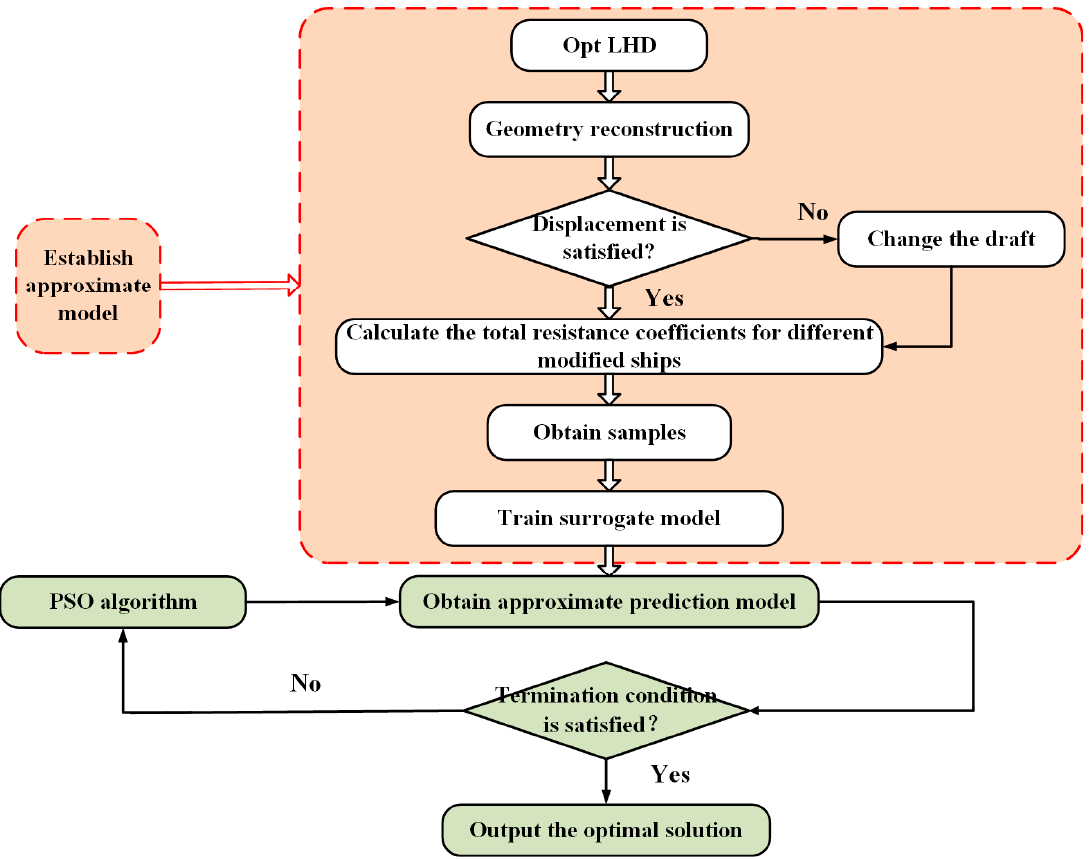
Figure 2. Flow chart of the ship hull form optimization loop.